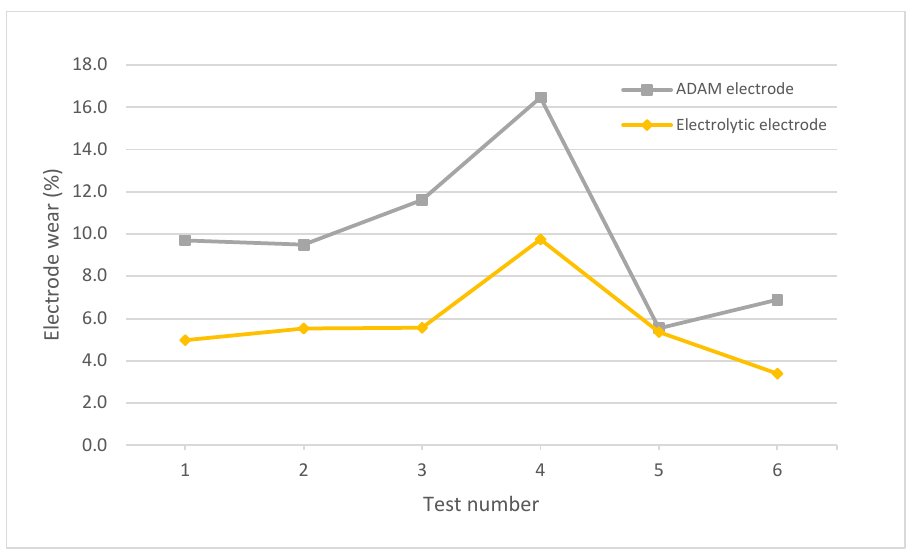
Figure 13. Wear rate of electrolytic and ADAM copper electrodes. According to the results, therefore, the wear rate of the ADAM electrode is higher than that corresponding to the electrolytic electrode. This behavior may be due to a lower internal cohesion of the material, probably caused by the internal structures and the defects generated both during the printing process and in the final sintering stage, generating structures that are not as homogeneous or consistent as those of the electrolytic mate- rials manufactured by casting. Other authors [24,25] already reported defects in parts gen- erated with ADAM technology, highlighting the lack of union between layers and adja- cent filaments deposited during the printing process (and not completely resolved during the sintering stage), as well as the internal porosity and orientation effects of the layer